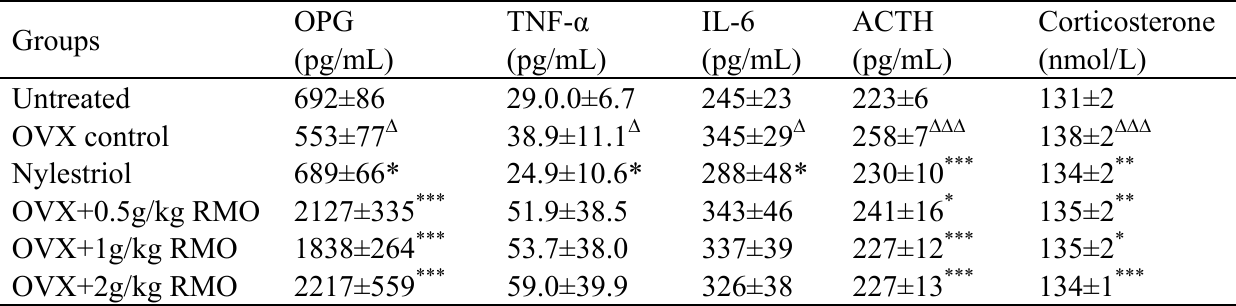
Table 5. Effects of RMO on serum OPG, TNF- α , IL-6, ACTH and Corticosterone levels in OVX rats